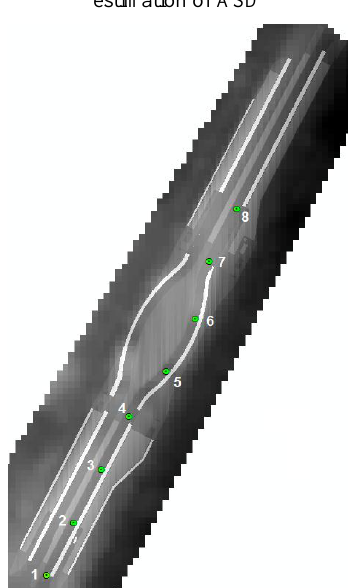
Figure 7. Representation of the algorithm used for the estimation of ASD